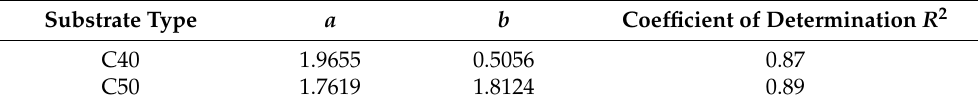
Table 5. Fi tt ing results for the pull-o ff results.